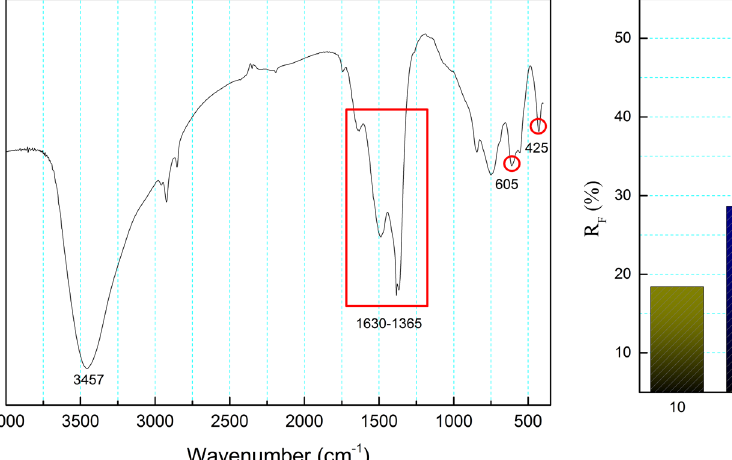
Figure 5: E ff ect of initial concentration on R F .